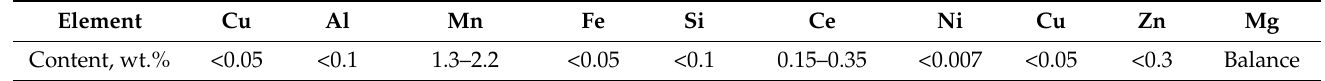
Table 1. The composition of magnesium alloy